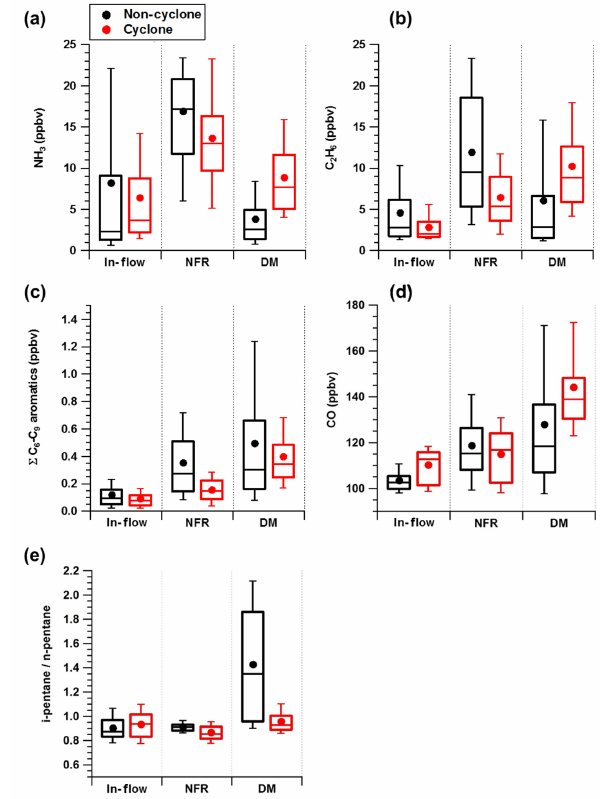
Figure 7. Statistical representation of the distribution of gas tracers (NH 3 , C 2 H 6 , P C 6 –C 9 aromatics, CO) and i -pentane to n -pentane ratios within the three study regions. The box and whiskers indi- cate 10th, 25th, 75th, and 90th percentiles, while the solid lines and circles mark the median and mean values, respectively.